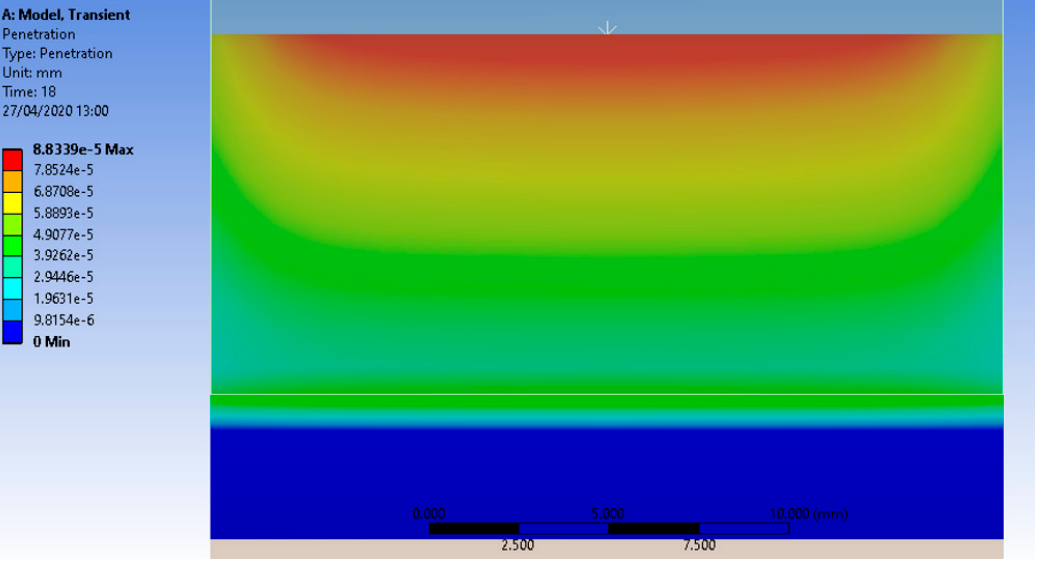
Figure 6. The pressure exerted by the sabot on the test piece surface.